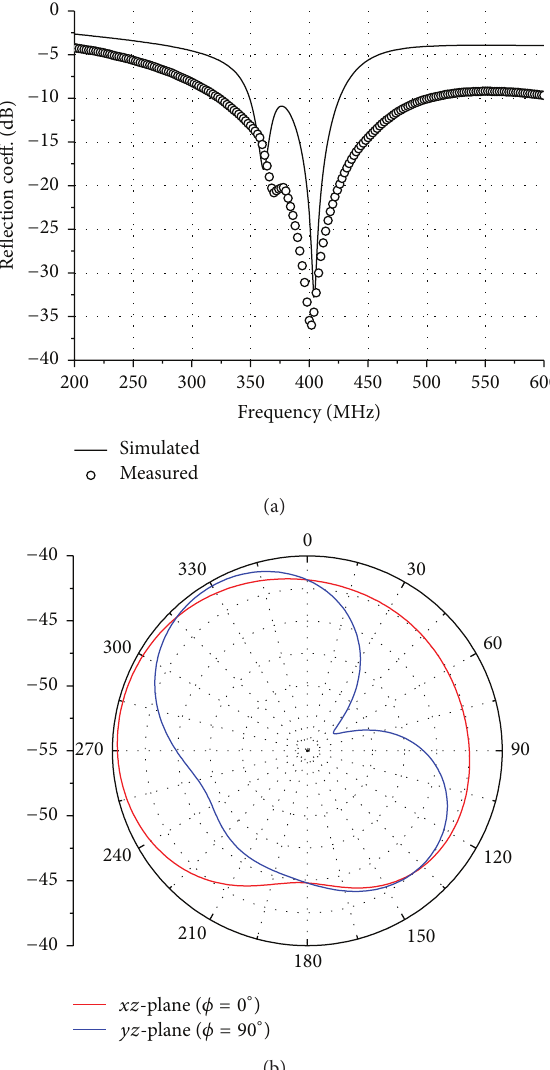
Figure 10: Performance of the designed MICS antenna: (a) simu- latedandmeasuredreflectioncoefficientfrequencyresponseand(b) simulated far-field gain radiation